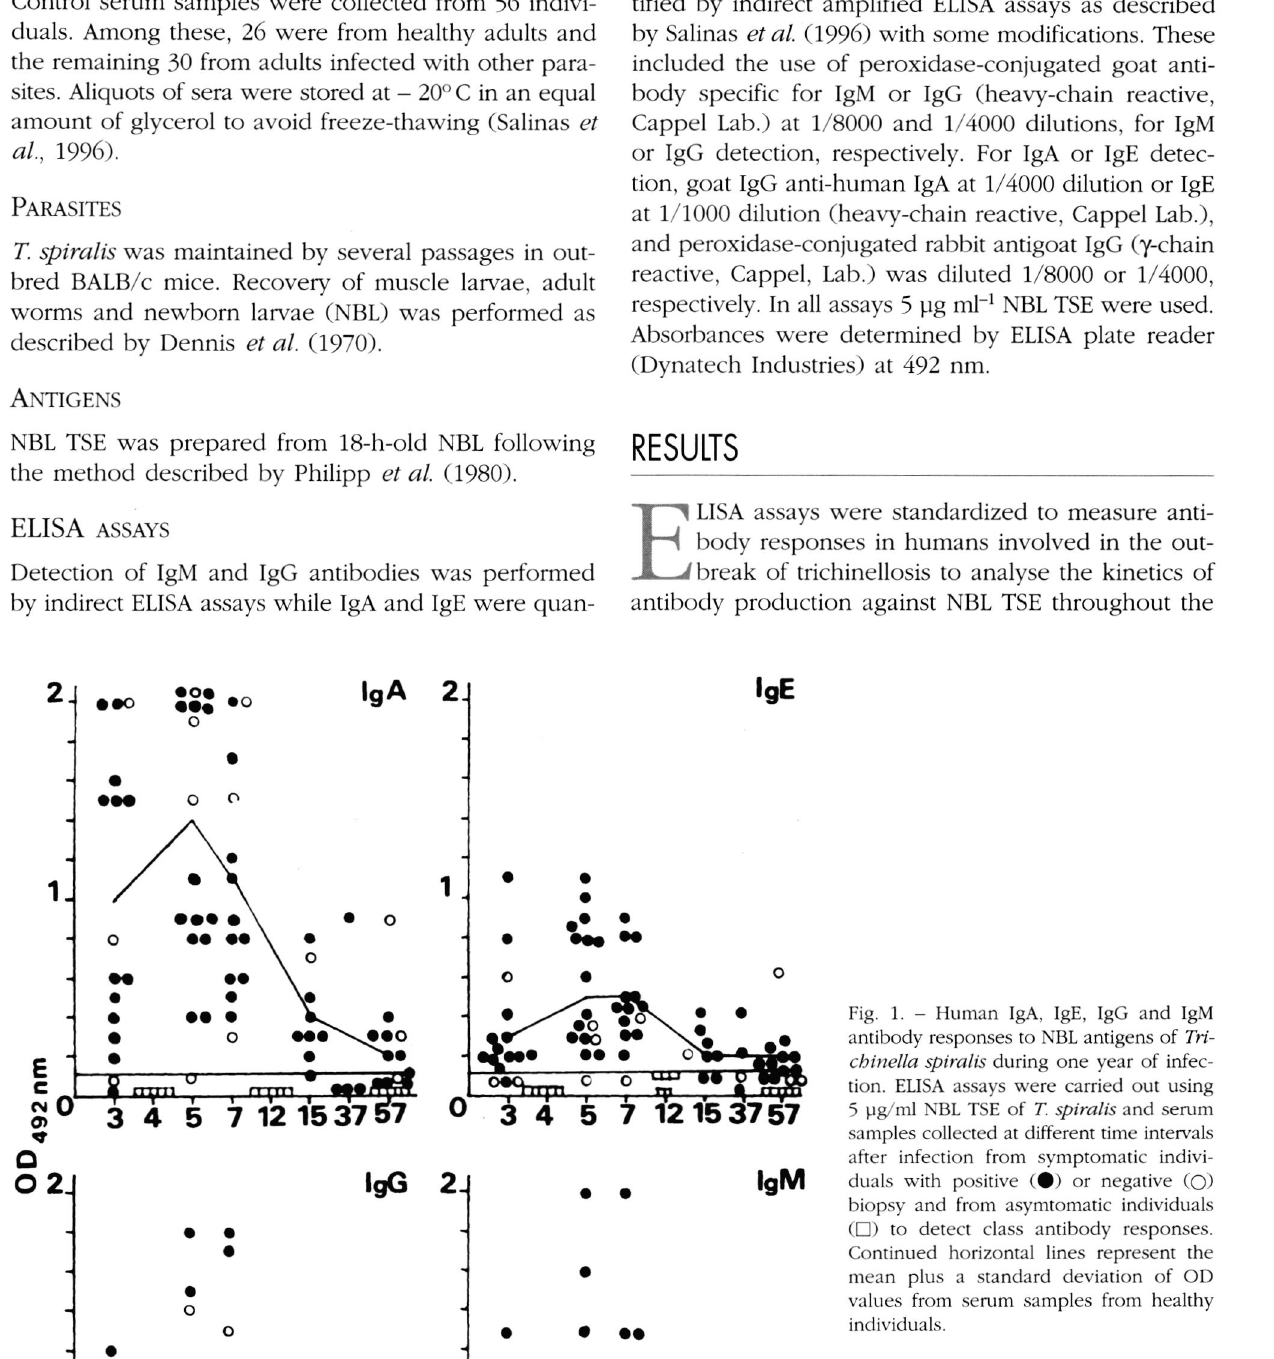
Fig. 1. - Human IgA, IgE, IgG and IgM antibody responses to NBL antigens of Tri- chinella spiralis during one year of infec­ tion. ELISA assays were carried out using 5 µg/ml NBL TSE of T. spiralis and serum samples collected at different time intervals after infection from symptomatic indivi­ duals with positive (•) or negative (O) biopsy and from asymtomatic individuals (•) to detect class antibody responses. Continued horizontal lines represent the mean plus a standard deviation of OD values from serum samples from healthy